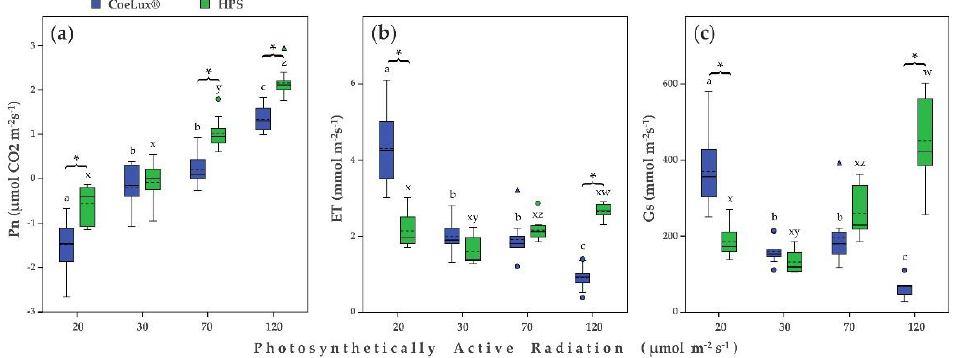
Figure 6. ( a ) Pn: net photosynthetic rate (μmol CO 2 m −2 s −1 ), ( b ) ET: evapotranspiration (mmol m −2 s −1 ), and ( c ) Gs: stomatal conductance (mmol m −2 s −1 ) for different light intensities. Blue and green bars indicate data of plants grown under the CoeLux ® and the HPS light types, respectively. Black asterisks indicate statistically significant differences ( p < 0.05) between plants grown under the CoeLux ® and the HPS light type within the same light intensity. Letters indicate statistically significant differences ( p < 0.05) between plants grown under different light intensities within the same light type. Vertical boxes represent approximately 50% of the observations and lines extending from each box are the upper and lower 25% of the distribution. Within each box, the solid horizontal line is the median value, whereas the dotted horizontal line is the mean.